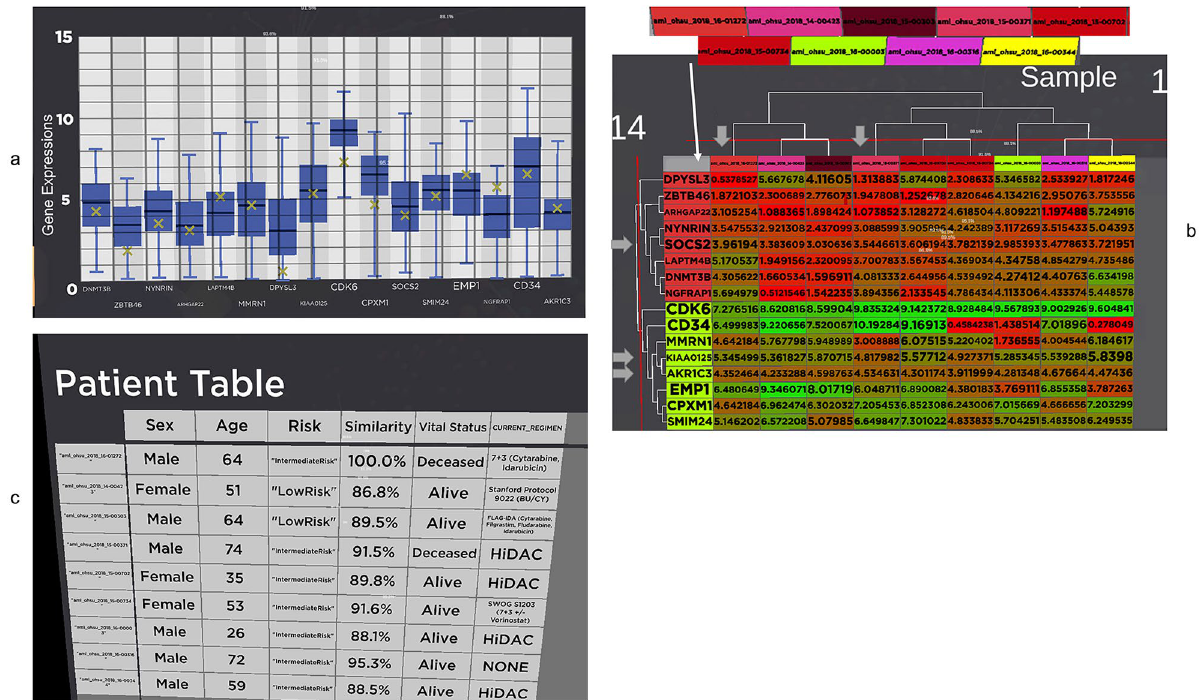
Figure 9. A walkthrough of an end-to-end analysis using the patient details panel and patient-to-group panel for overview and details analysis to unleash the knowledge embedded deep in the data for our POI and POCs. ( a ) First, the analyst can investigate the gene-of-interest, “CDK6”, expression value for the POI to see if it falls in the IQR range or an outliner. The analyst then can use the POCs suggested by the Decision Support System to investigate why these POCs cohort mostly survived the illness. ( b ) The analyst can then inspect the gene expression value for the POI compared to the POCs and conduct a hierarchical clustering analysis on the heatmap. Since the grouping was based on “KIAA0125”, “SOC2” and “AKR1C3” gene combination, the analyst can visually compare the differential expression for these three genes for POI and POCs. Since the similarity was done on these three genes, it made sense that those values shown in ( b ) were close to each other. ( c ) The medical history for all the patients. In this scenario, the analyst would find the POI and patient "aml_ohsu_2018_15- 00371" were dead; and compare the regimen used for these patients. The visual comparison reveals that the regimen used for our POI is not the same as any of the rest of the POCs.